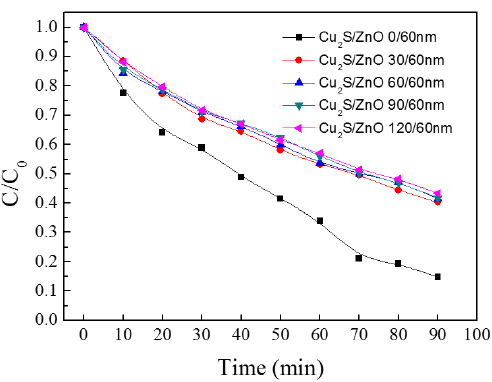
Figure 12. The photocatalytic activity of Cu 2 S/ZnO/glass complex films for different thickness.